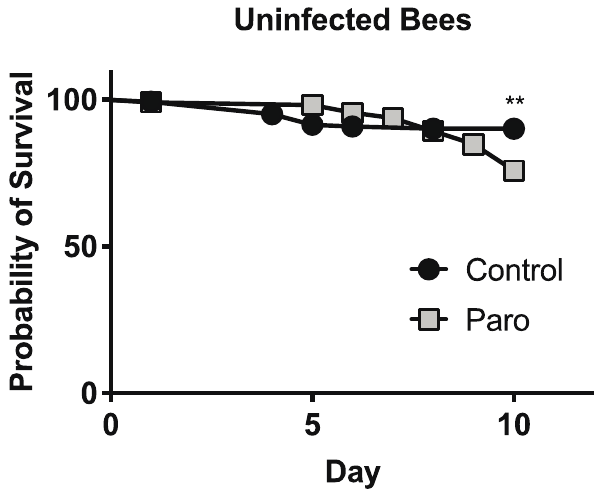
Figure 3. Paromomycin impacts honey bee survival . Survival of individual uninfected newly emerged bees fed with a sucrose solution alone ( n = 142) or containing 1 mg /mL of paromomycin emerged bees fed with a sucrose solution alone ( n = 142) or containing 1 mg/mL of paromomycin ( n = 112) for 10 days. Statistical significance is noted as ** for p < 0.01. ( n = 112) for 10 days. Statistical significance is noted as ** for p <